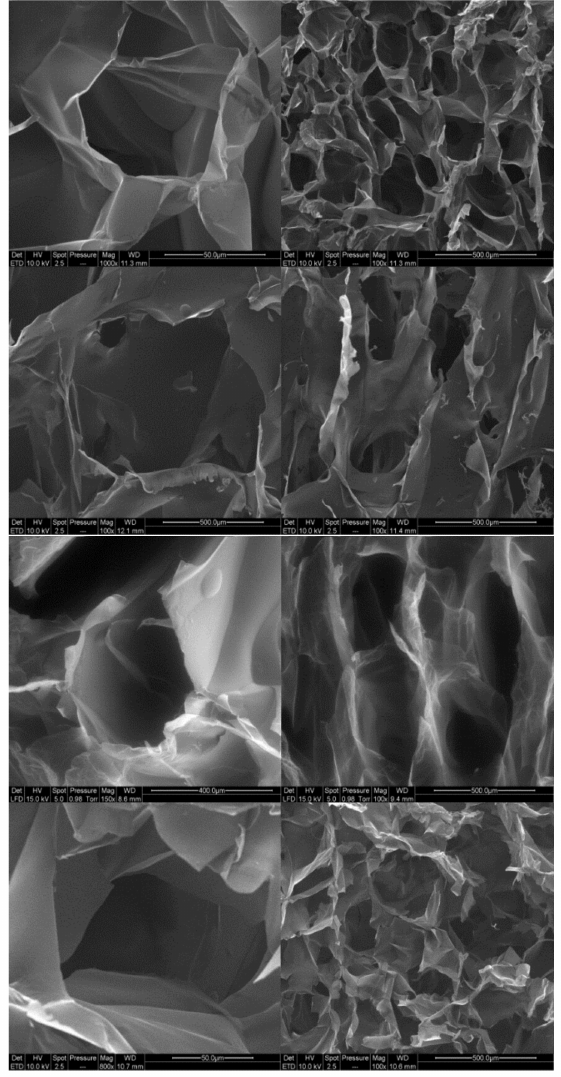
Figure 7. SEM images for toCNF cryogels. From Top to bottom: cryogels from suspensions 1 / 2 / 3 / 4. In addition, we can observe that the structure of the cell walls for modified toCNF cryogels presents more structural deflects (holes and folds) than the unmodified toCNF one. Compression tests were carried out on cryogels prepared from the four compositions for both charge contents. Typical stress-strain curves for each composition are presented in Figure